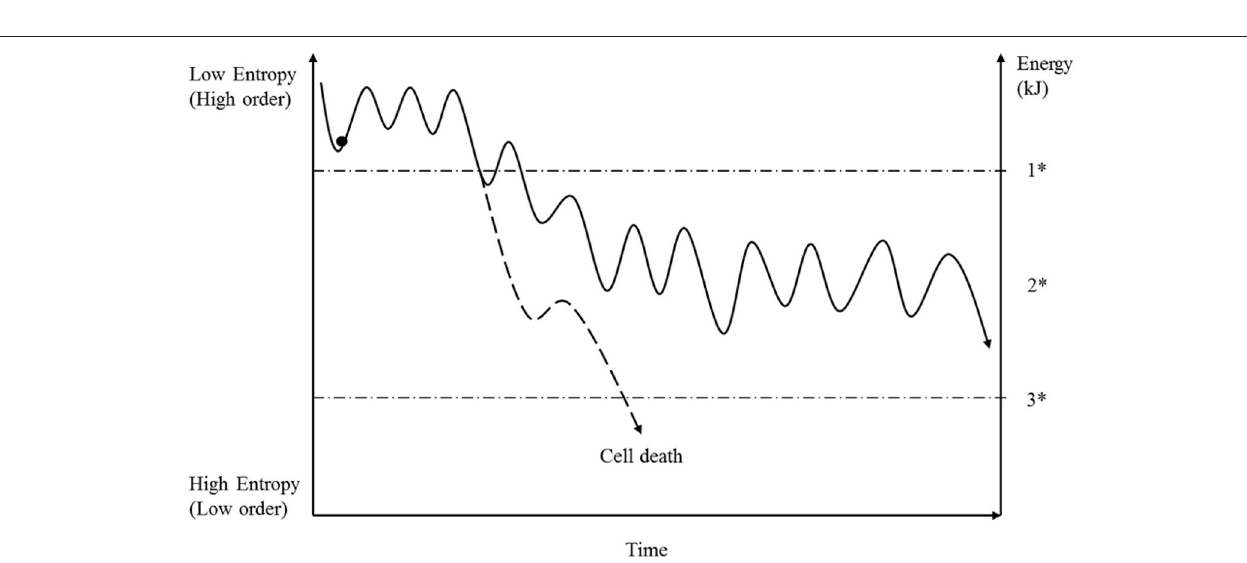
FIGURE 4 | Under normal conditions a cell permanently ingests fuel and produces energy molecules such as ATP by respiration. For various reasons, the energy concentration under physiological conditions is not stable (see text) resulting in a reversible fluctuation of cellular entropy. As long as the energy concentration does not fall below a specific level, then all cellular mechanisms will run properly. But if the energy deficit exceeds that value (1*), then all cellular mechanisms will be affected, to a greater or lesser extent, and the initially ordered systems will transition into a metastable state (2*). The future of the cell now depends on the degree of the energy loss and the particular details of the systems affected. Based on these conditions, the cell has to achieve a new stable state, depending on the availability of matter and information. Because energy loss has an immediate influence on matter transportation and the preservation of information, it is difficult for the cell to establish a stable state (see Figure 2 ). Moreover, if the energy concentration is too low, then the cell dies